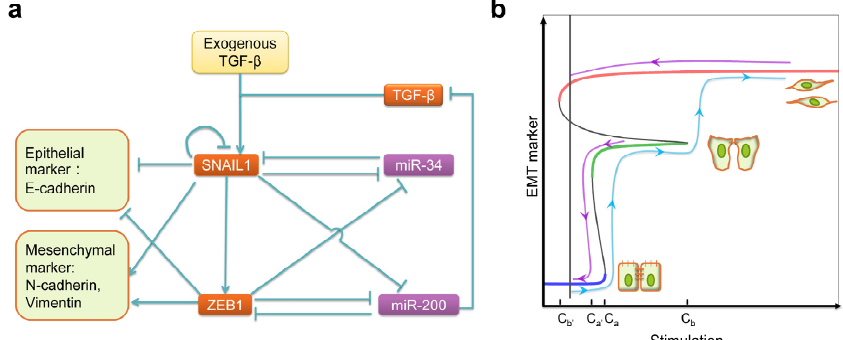
Figure 3. Systems biology study on the core EMT network. ( a ) Core regulatory network of TGF ‐β induced EMT revealed by experimental studies. Point arrows represent activation, and blunt ones represent inhibition; and ( b ) mathematically ‐ predicted bifurcation diagram. Also shown are the corresponding dose ‐ response (D ‐ R) curves that are more familiar to experimentalists. Notice that the D ‐ R curves are different for cells starting from different phenotypes and treated with increasing (blue curve) and decreasing (purple curves) exogenous TGF ‐β , respectively. This history ‐ dependent hysteresis is a signature of bistable dynamics. The predicted bifurcation diagram has been experimentally confirmed in MCF10A cells. Adapted from [142,144].